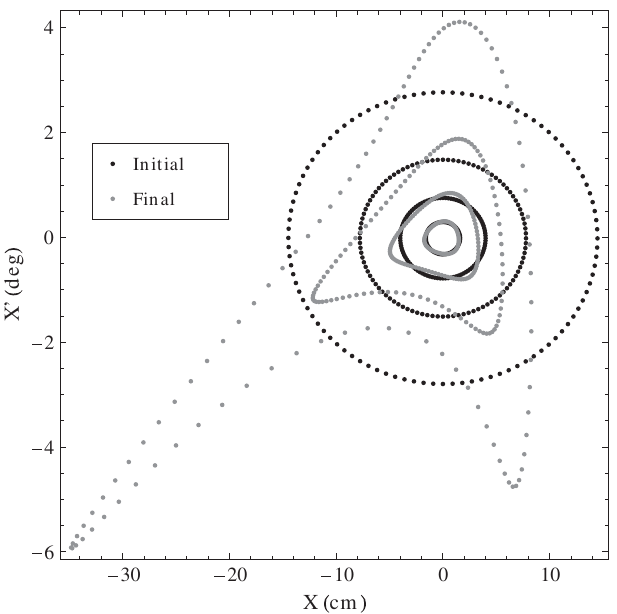
FIG. 49. Phase space ellipses of four emittances that result in smears of 0.1, 0.25, 0.5, and 1. The black dots represent the particles at the start of the lattice while the grey dots represent the same particles at the end. Increasingly large initial emittan- ces are used simply for clarity in the